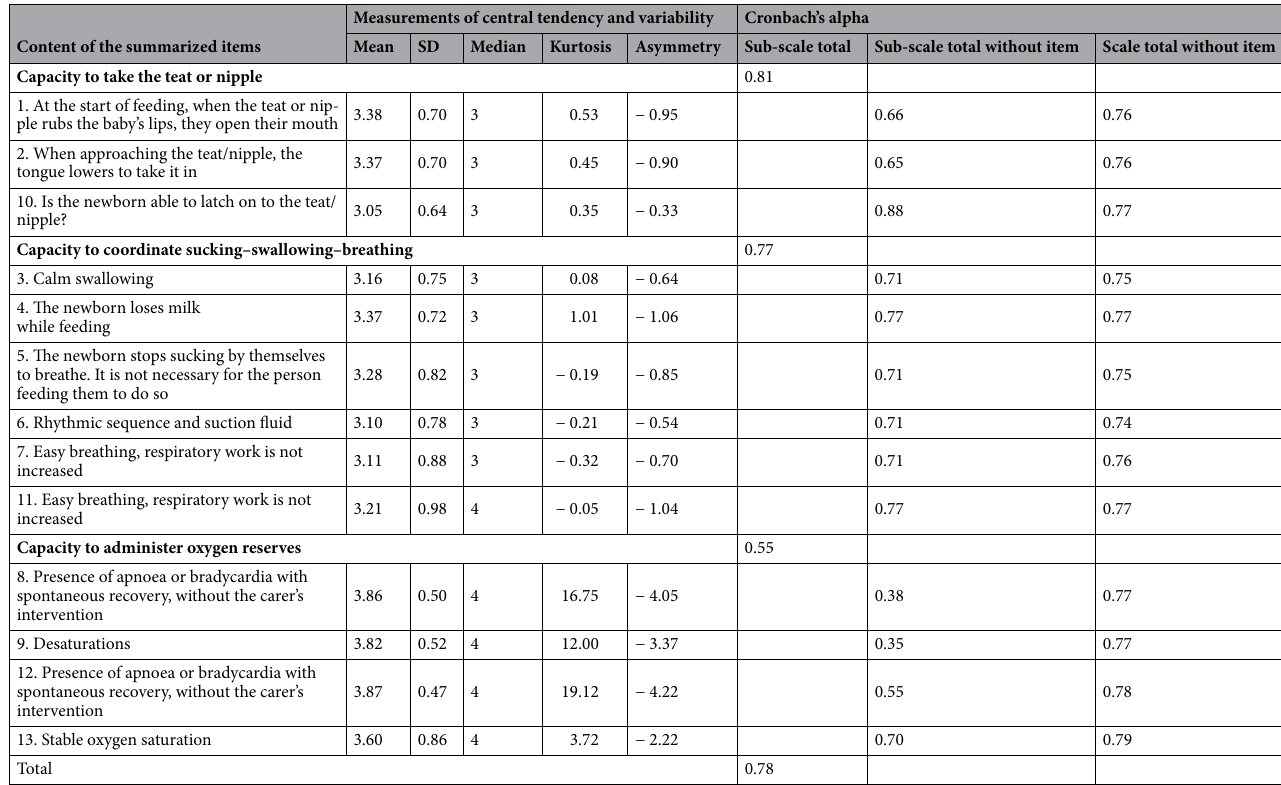
Table 1. Descriptive statistics of items and internal consistency coefficient (Cronbach’s alpha) for the OFEATINg scale.